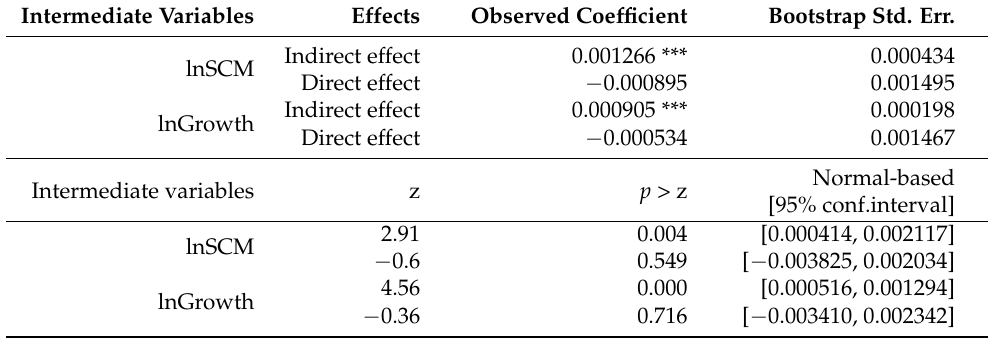
Table 6. Results of the intermediate effects